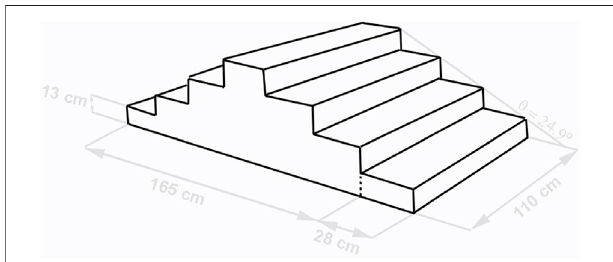
FIGURE 1 | Staircase dimensions. The experimental environment conditions of the